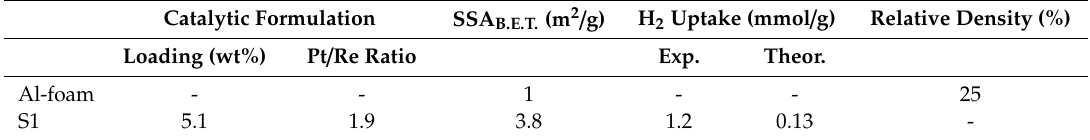
Table 3. Structured catalyst characterization.